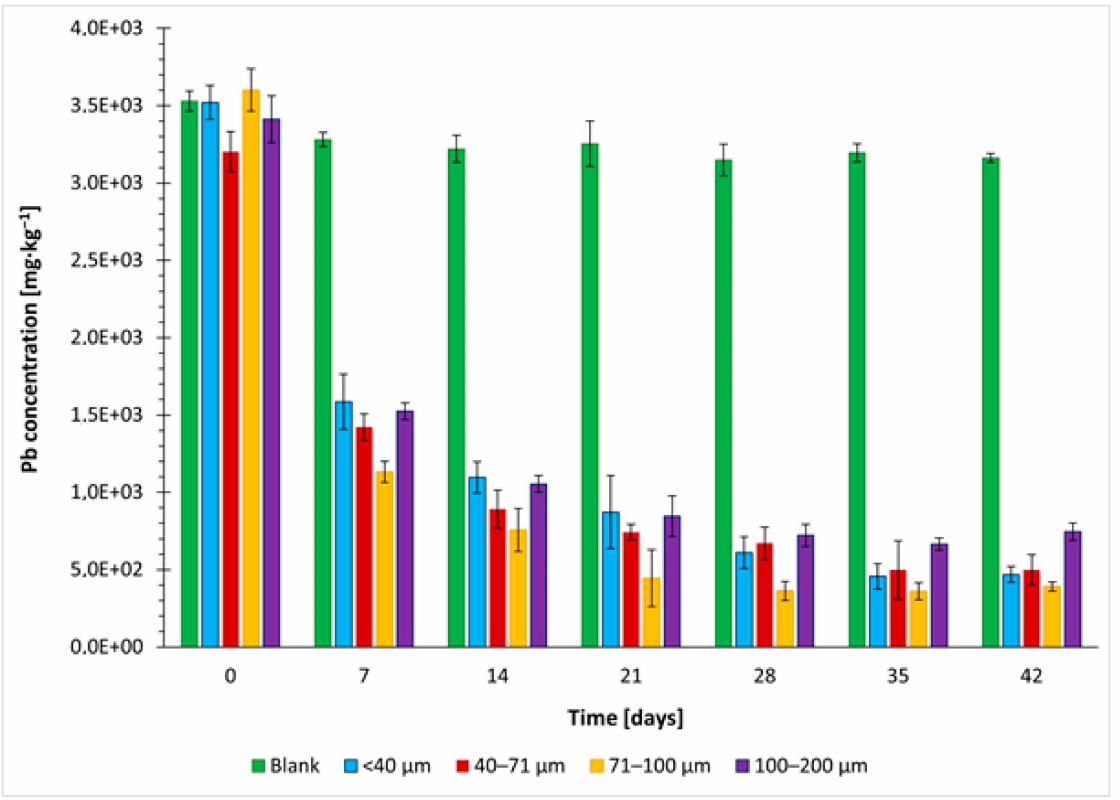
Figure 12. Concentration loss of Pb in waste material for the di ff erent grain